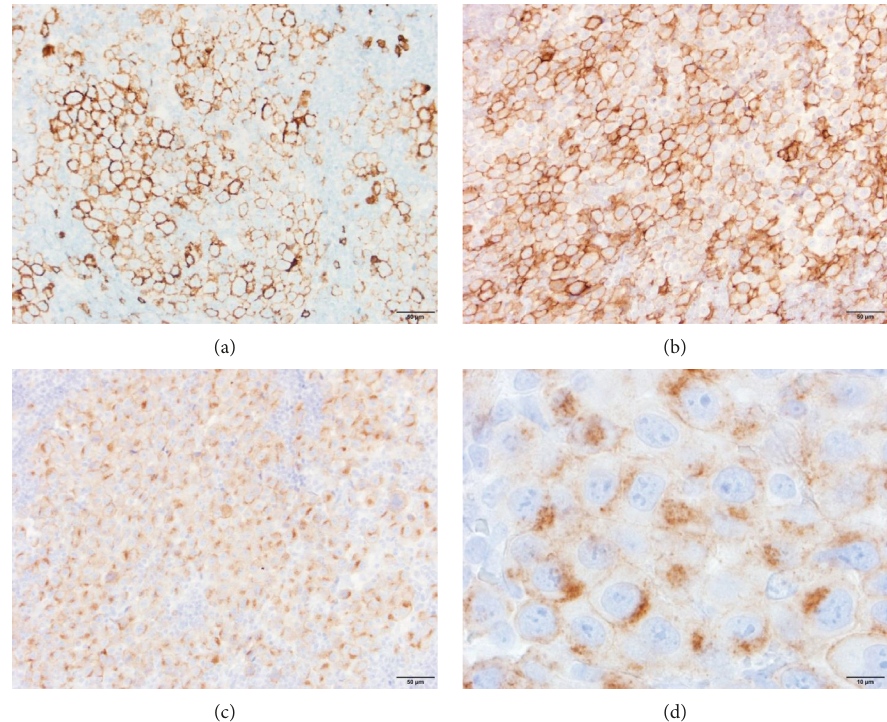
Figure 3: Additional immunohistochemical stains of tumor cells. The tumor cells also express CD138 (a), CD33 (b), and ALK (c). Higher magnification (100x, oil) of ALK in panel (d) demonstrates a cytoplasmic granular pattern highly suggestive of CLTC-ALK fusion protein expression. Images (a), (b), and (c) are all at 20x